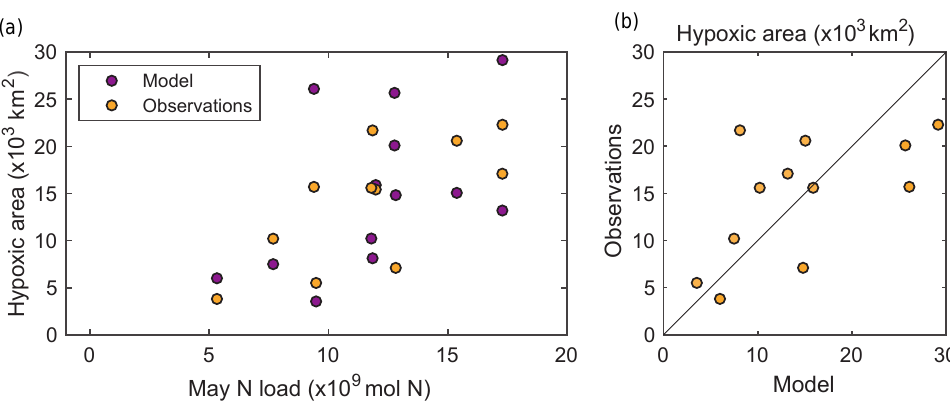
Figure 5. (a) Simulated midsummer hypoxic area for current nutrient loads plotted over May N load in comparison to observed values by Obenour et al. (2013) for the years 2000 to 2011. (b) Observed over simulated midsummer hypoxic area for the same years.